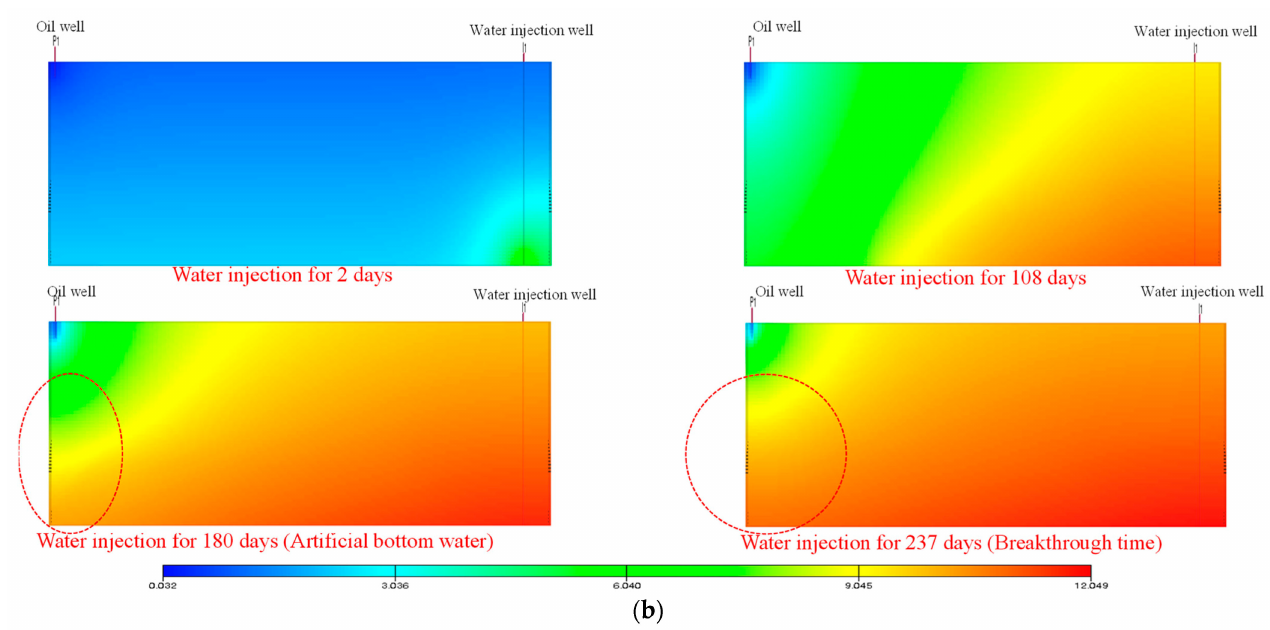
Figure 6. The change of the oil saturation ( a ) and pressure distribution ( b ) by numerical simulation.